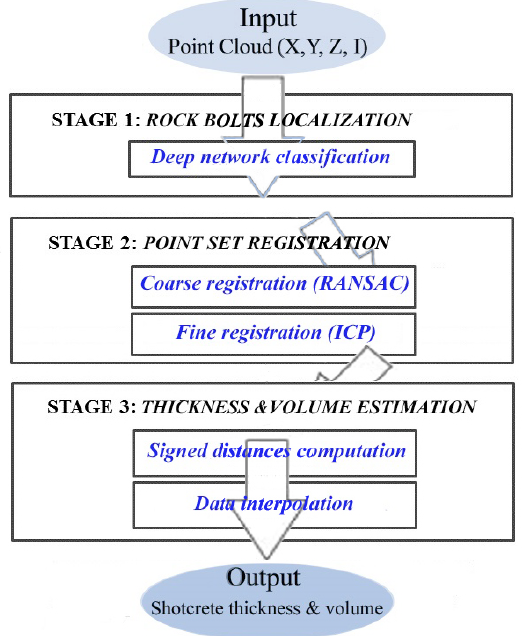
Figure 1. Algorithm overview for thickness and volume estimation of sprayed concrete.